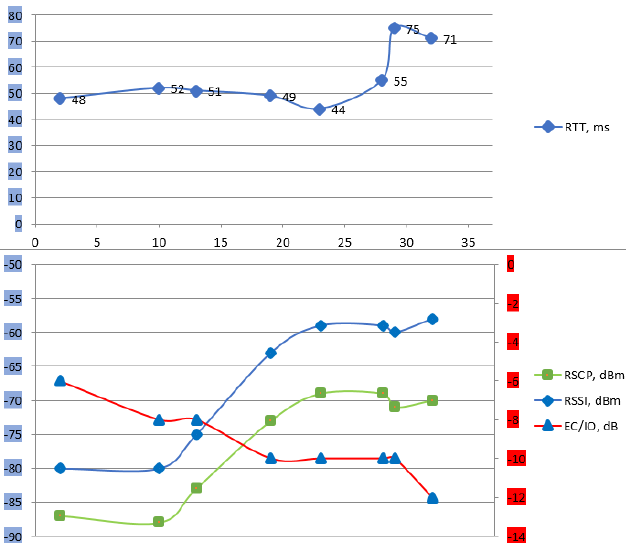
Fig. 5. Network performance for the static UE at different altitudes in 3G HSPA+ mode of operation. Averaged RTT values are shown in the first graph, in milliseconds. Network performance indicators are shown in the second graph: RSSI and RSRP are in the left y axis, in dBm, Ec/Io is in the right y axis, in dB. Altitude is in the x axis and represented in meters.